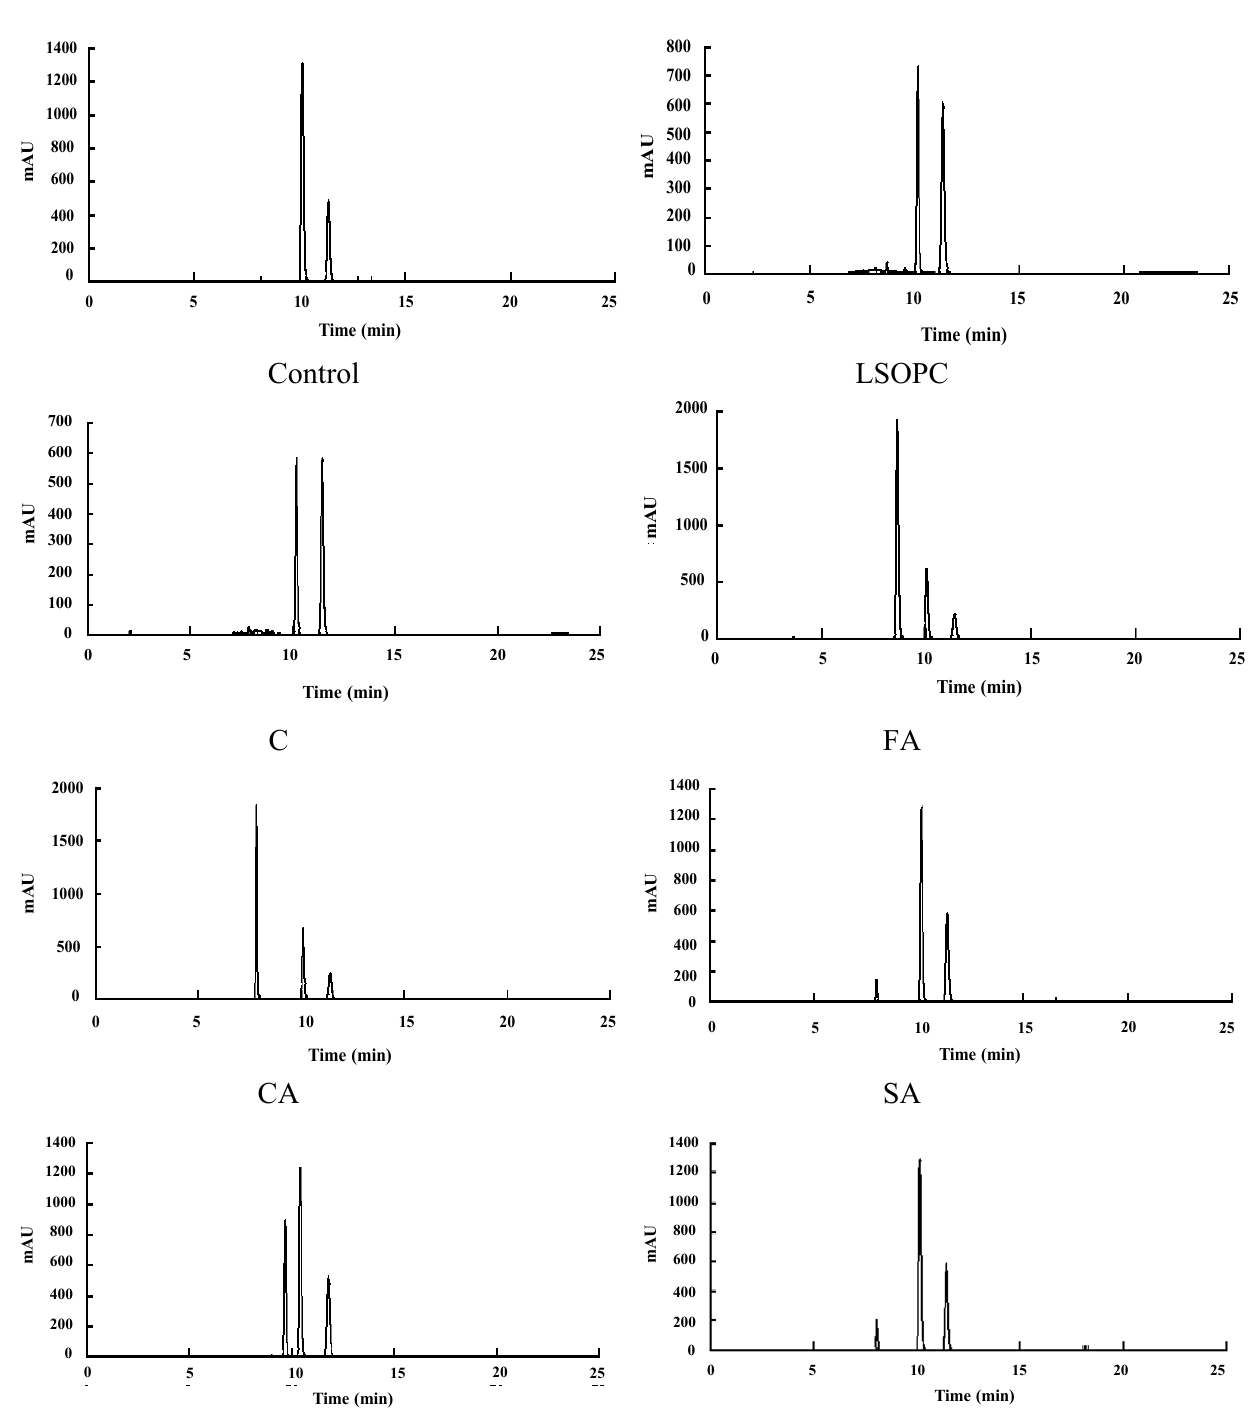
Figure 3. Chromatogram of the LSOPC-methylglyoxal adducts and metabolite-methylglyoxal